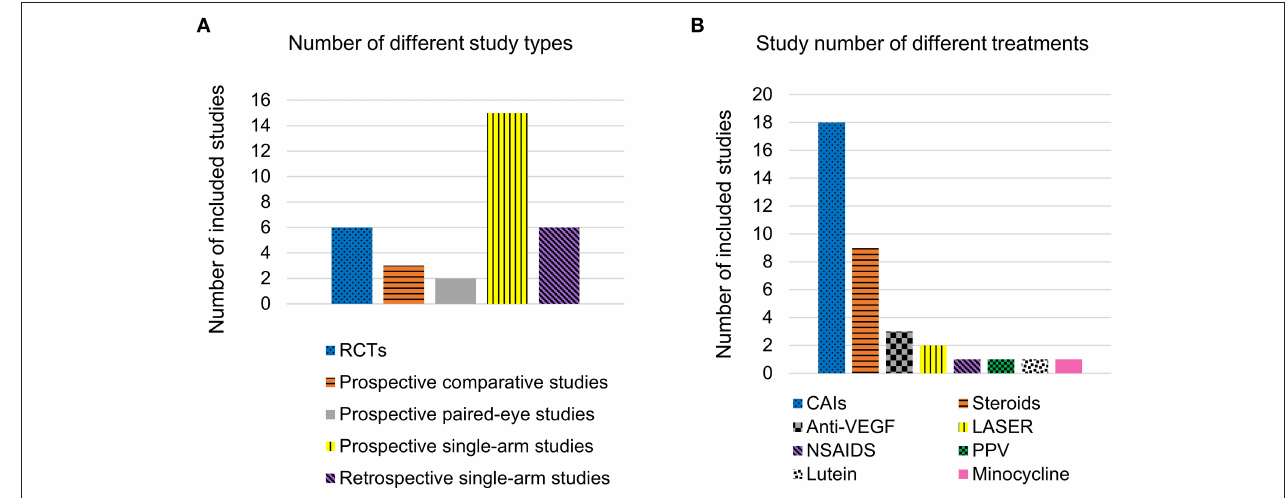
FIGURE 2 | Distribution characteristics of included studies. (A) Number of different study types; (B) Study number of different treatments.